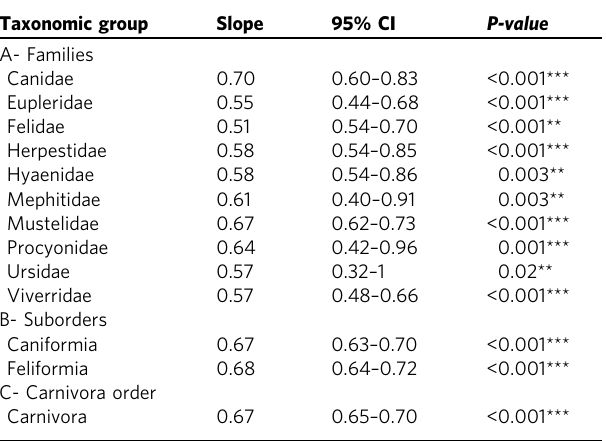
Table 1 Allometric slopes estimated for (A) the carnivoran families, (B) the two suborders, and (C) the entire Carnivora